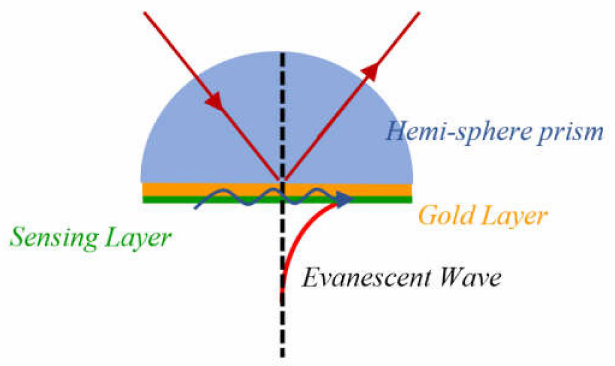
Figure 6. Scheme of surface plasmon wave and penetration depth of evanescent